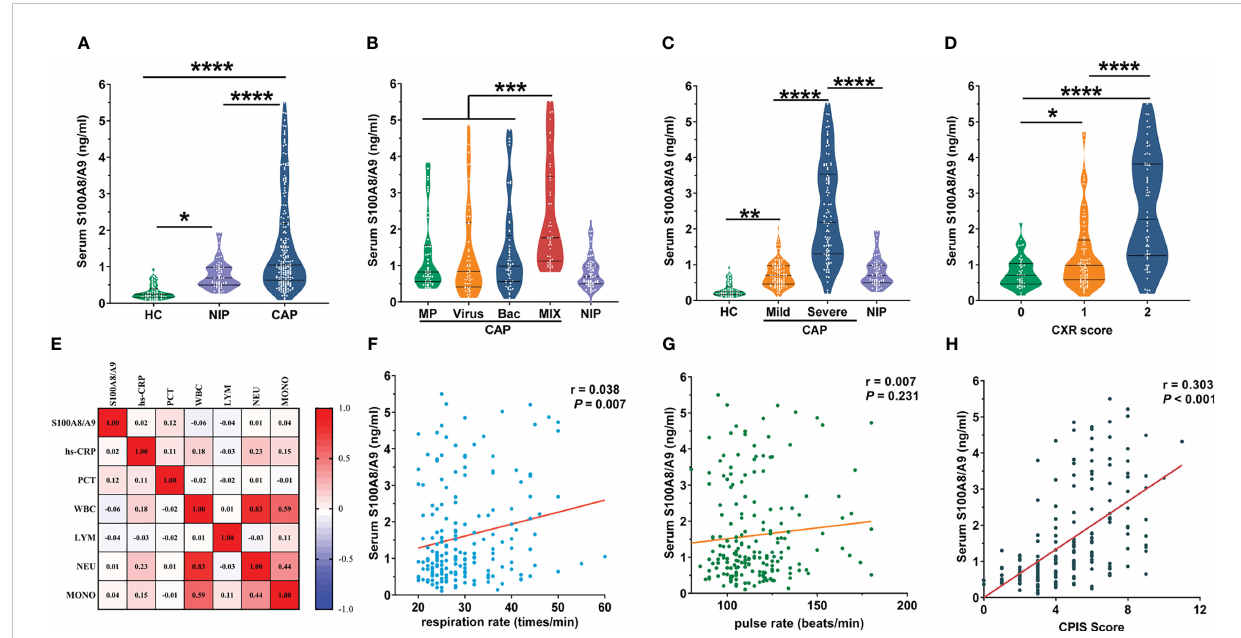
FIGURE 2 The levels of serum S100A8/A9 between groups and its correlation with other indices. (A) Serum S100A8/A9 in CAP patients and control subjects. (B) Due to the different types of pathogens causing CAP, based on the corresponding pathogenic test results, we divided the 195 children with CAP into four groups: bacterial group (n = 49), viral group (n = 49), mycoplasma group (n = 52) with a single infection type, and mixed infection group (n = 45) with more than two infection types. The graph shows serum S100A8/A9 in different infected etiologies of CAP patients and control groups. (C) The 195 recruited pediatric patients with CAP divided into mild group (n = 97) and severe group (n = 98) based on the criteria of the guideline of CAP in children (Commission, 2019). The graph shows serum S100A8/A9 in different severity of CAP patients and control subjects. (D) Correlation of serum S100A8/A9 with common laboratory indicators of the severity of in fl ammation. (E) Serum S100A8/A9 in different Chest radiography (CXR) scores in CAP children. (F, G) Correlation of serum S100A8/A9 with respiration rate and pulse rate. (H) Correlation of serum S100A8/A9 with CPIS Scores. Serum S100A8/A9 was detected using ELISA. All data were expressed as mean ± SEM. Correlations were analyzed using the Spearman correlation analysis. * P < 0.05, ** P < 0.01, *** P < 0.001, **** P <